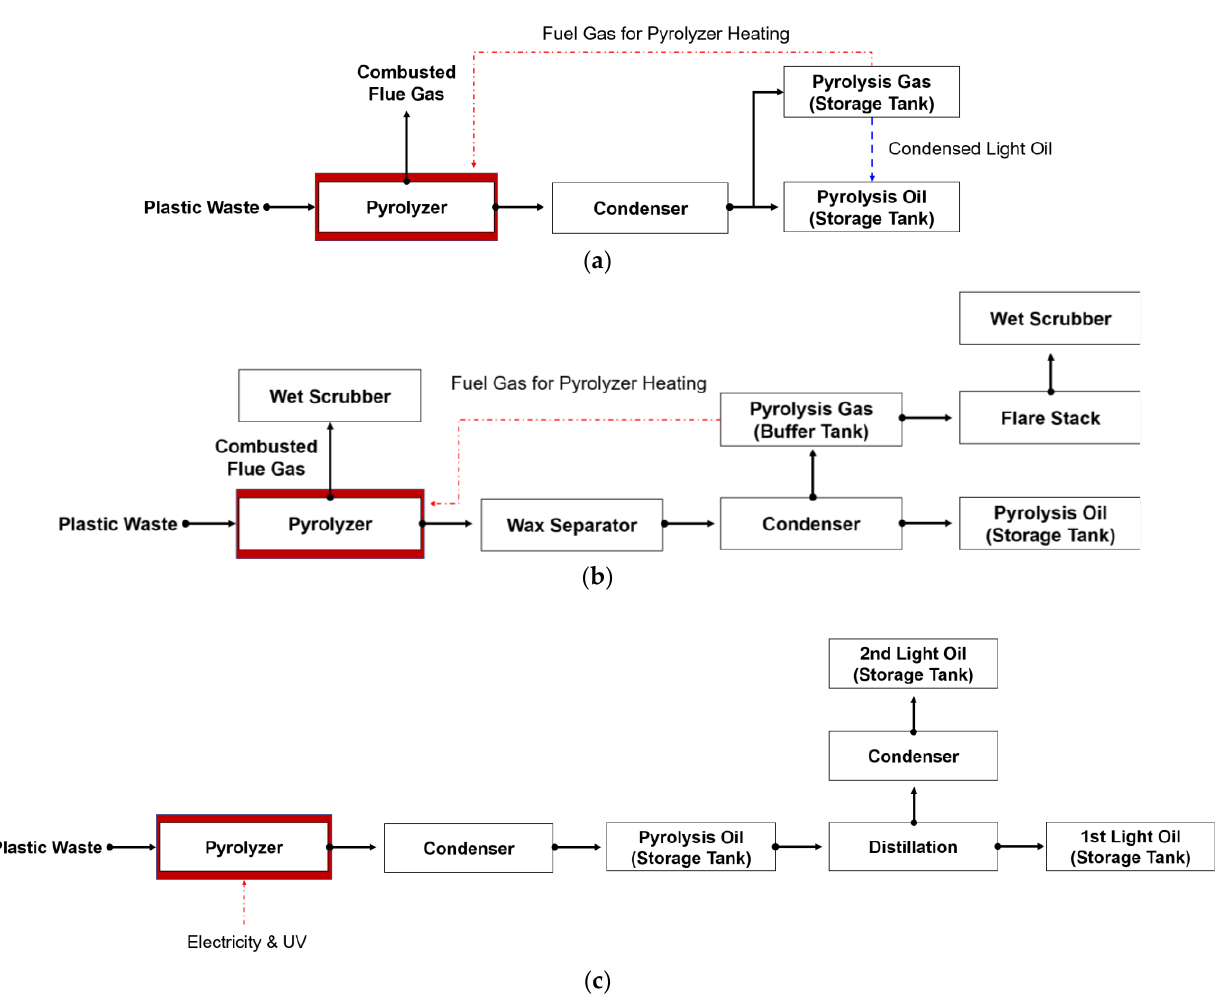
Figure 1. Schematic diagram of pyrolysis facilities using plastic waste. ( a ) Facility A (pyrolyzer: screw reactor); ( b ) facility B and C (pyrolyzer: rotary drum reactor); ( c ) facility D (pyrolyzer: fixed- bed reactor).